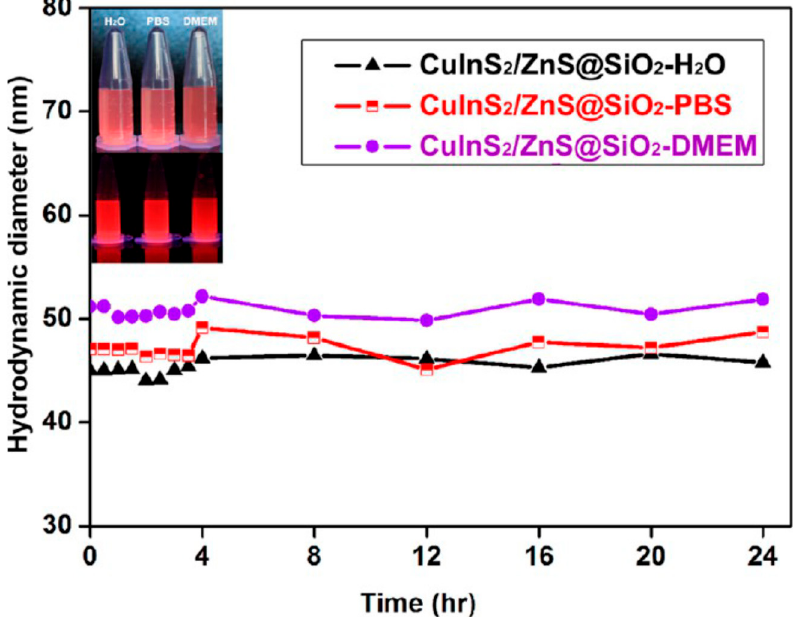
Figure 16. Hydrodynamic diameters of CuInS 2 /ZnS@SiO 2 nanoparticles in Deionised water, PBS, and DMEM incubated at 37 °C. Inset: digital photographs of CuInS2/ZnS@SiO2 in different media under room light (upper) and UV light (lower) [109].